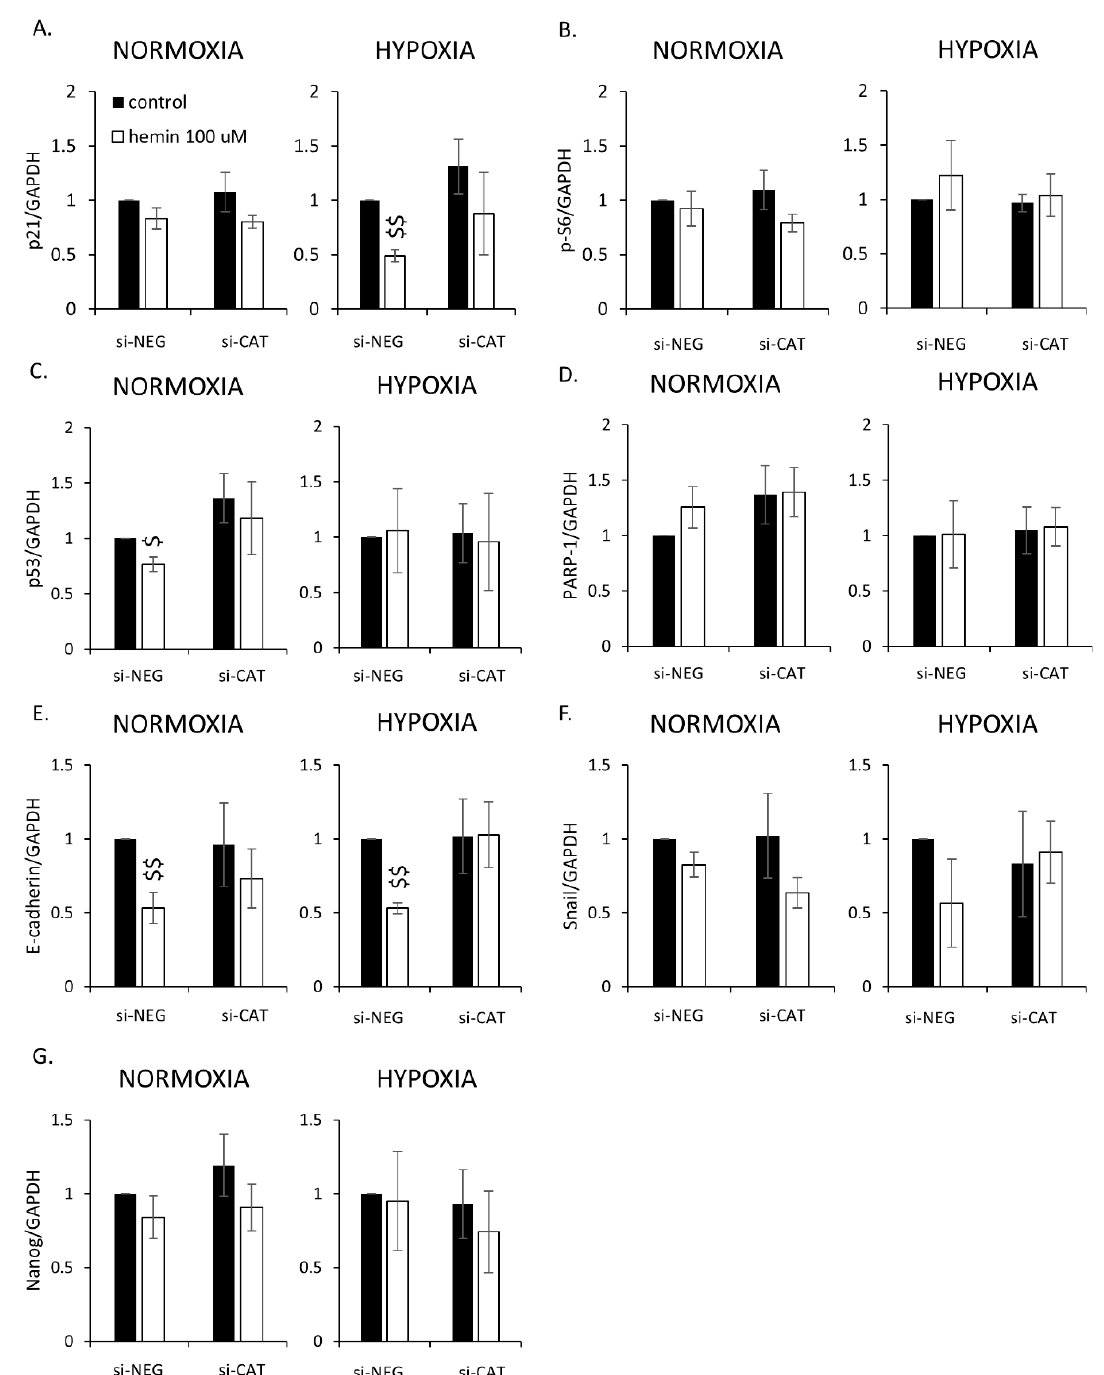
Figure A9. Evaluation of the protein expression in HCT116 cells, where gene encoding CAT was silenced with the use of siRNAs: cell cycle inhibition and EMT markers. Cells were cultured in parallel in normoxia or hypoxia. Cells were treated with 2.5 µM IRINO and exposed to 100 µM hemin. Control cells were subjected to IRINO and NaOH. Quantification is based on the densitometry analysis performed with the use of ImageJ software. Data are shown as the ratio of the protein amount to respective protein loading control l (GAPDH): ( A ) p21; ( B ) p-S6; ( C ) p53; ( D ) PARP-1; ( E ) E-cadherin; ( F ) Snail; ( G ) Nanog. Each bar represents mean ± SEM, n ≥ 3; $ p < 0.05, $$ p < 0.01—control vs. hemin 100 µM.